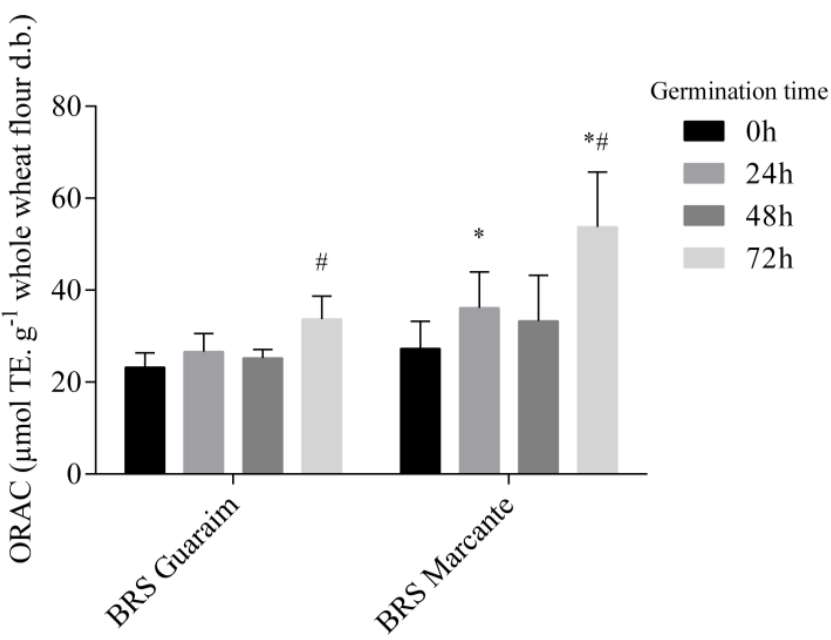
Figure 3. Changes in the oxygen radical absorbance capacity (ORAC) of the free phytochemical fraction of germinated wheat. # Significantly different ( p < 0.05) from the same cultivar at 0 h. * Significantly different ( p < 0.05) from BRS Guaraim at the same germination time. n = 6. Although BRS Marcante had a higher content of free phytochemical compounds than BRS Guaraim (Table 2), the peroxyl radical scavenging capacity of both cultivars was similar before germination (Figure 3). The compounds that most contribute to this antioxidant activity are phenolic acids and flavonoids [53]. In both cultivars, there was an increase in the antioxidant capacity after 72 h of germination ( p < 0.05), and this increase was higher for BRS Marcante, which had a higher antioxidant capacity than BRS Guaraim at 24 h (58% higher) and 72 h (41% higher; p <